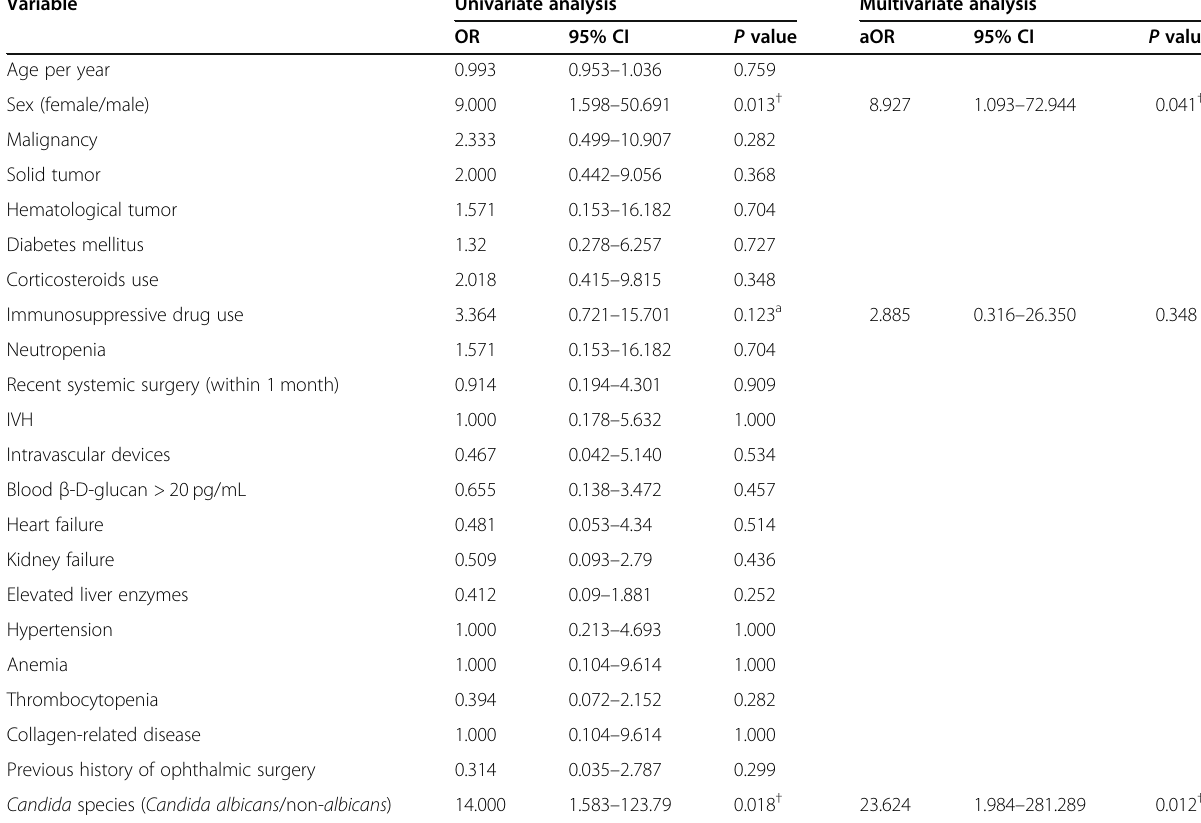
Table 2 Results of logistic regression analysis of factors associated with the development of probable OC Variable